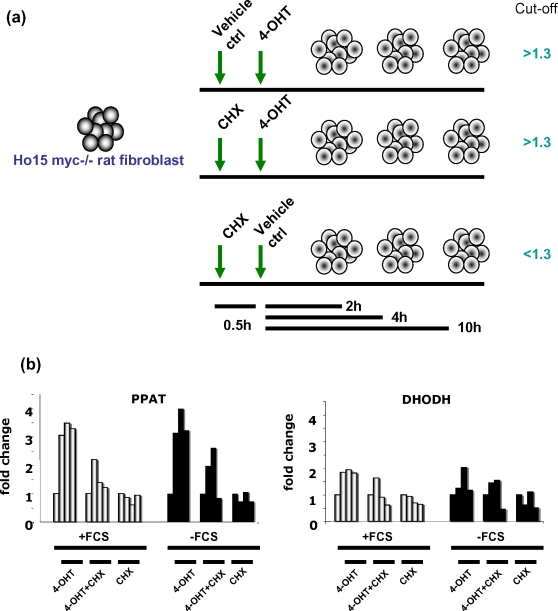
PPAT and DHODH are direct c-MYC target genes in the HO.15 MYC-ER system.(A) The experiment design was shown in the diagram. We set the following criteria to identify direct MYC target genes: 1) A>1.3 fold induction of expression by 4-OHT with or without cycloheximide; 2) A<1.3 fold induction of expression by cycloheximide alone. (B) PPAT and DHODH fulfilled the criteria in the majority of the experiments. Bar graphs represent mRNA expression of either PPAT or DHODH relative to 18S rRNA control as determined by real-time PCR in HO.15 MYC-ER cells with regular medium (+FCS; light bars represent the expression at 0, 2, 4,10 hr) or with serum starvation (-FCS; black bars represent the expression at 0, 2, 4,10 hr). One representative experiment is shown for each group from 4 biologically independent experiments.